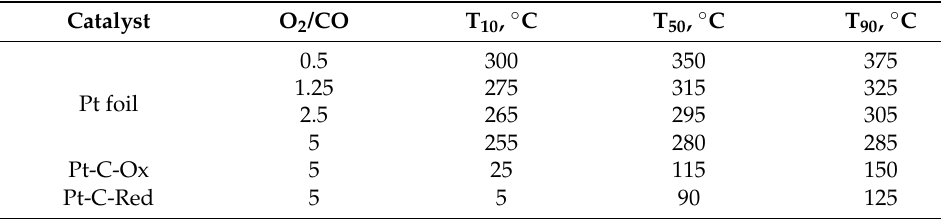
Table A1. Catalytic characteristics of the Pt foil and the Pt-C catalyst.